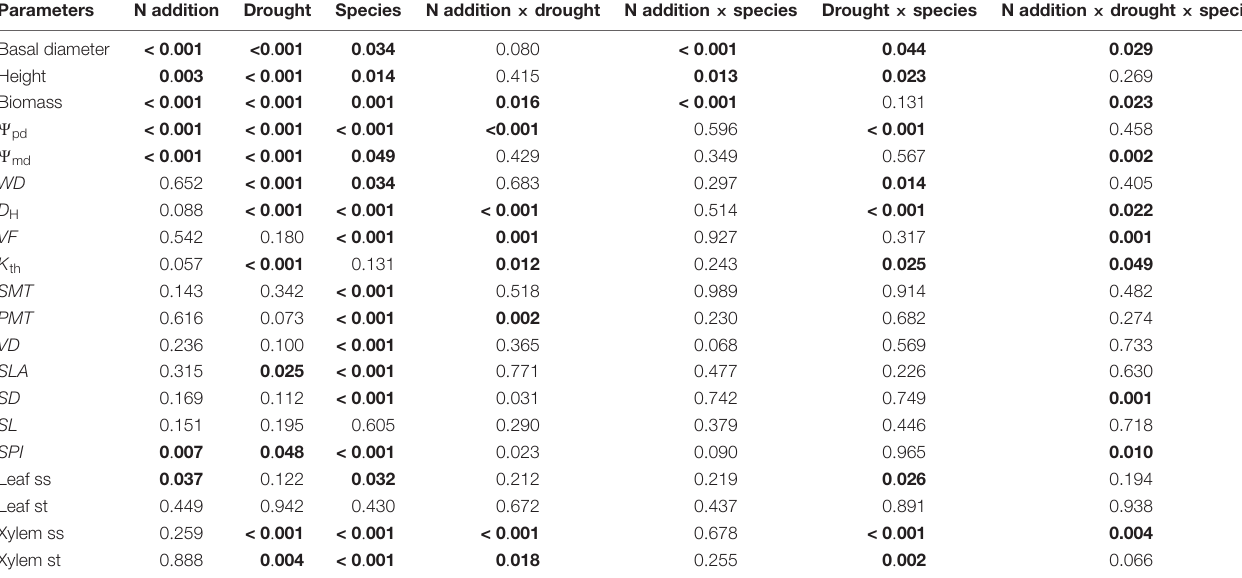
TABLE 1 | Probability values of three-way ANOVAs for the effects of N addition, drought stress, and tree species on each of the physiological and anatomical traits.